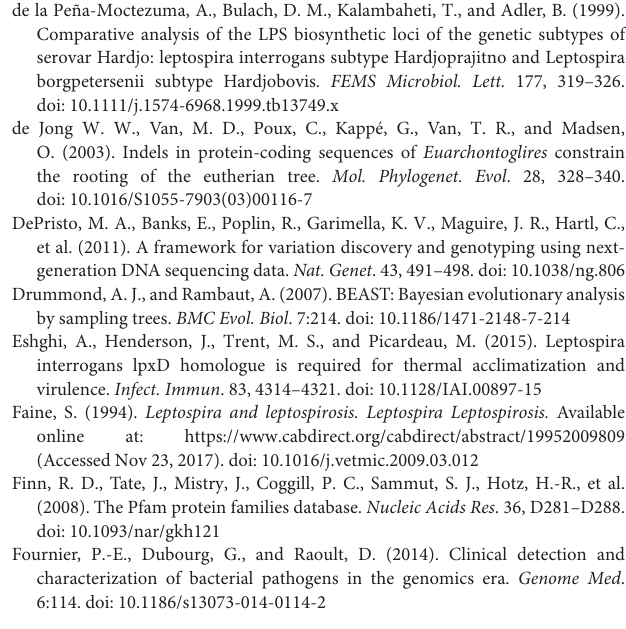
Table S6 | List of Insertion and deletions (Indels) identified in L. interrogans serovars from this study. Table S7 | Primers employed for